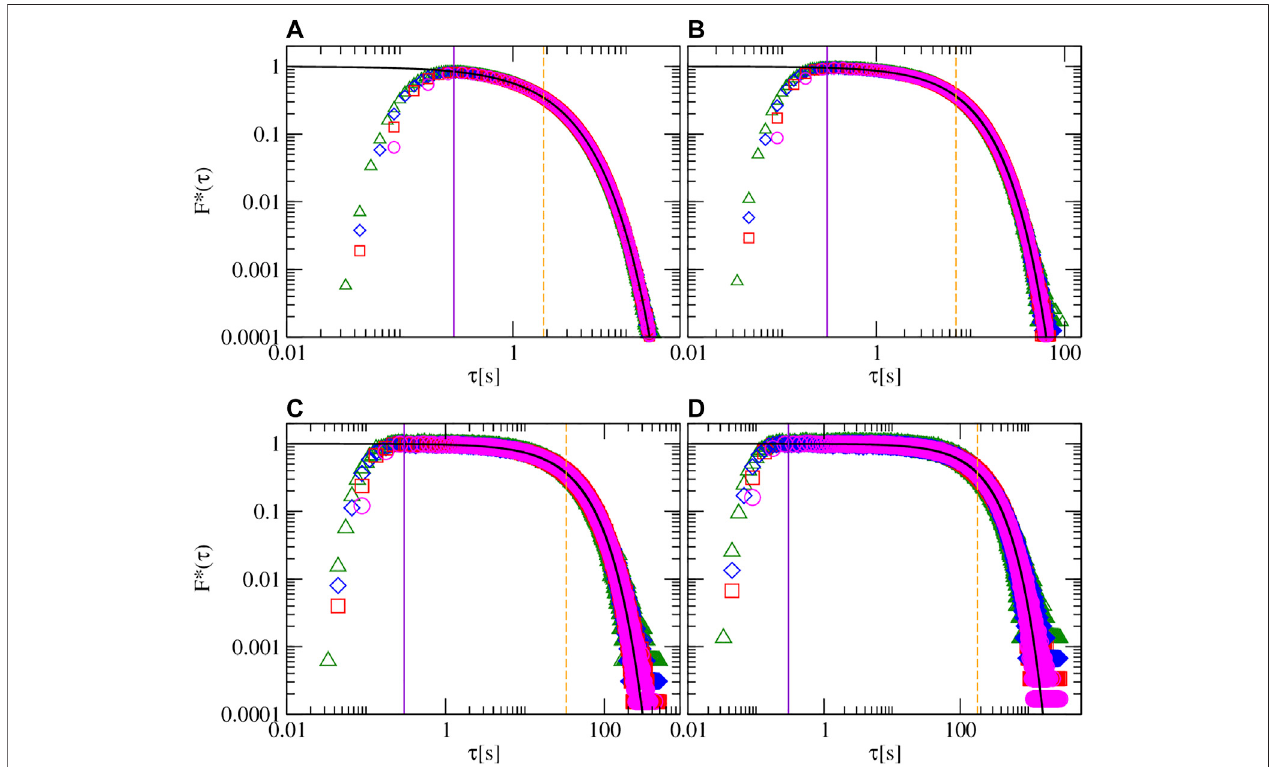
FIGURE 12 | (Color online): Normalized histograms of the fi rst passage times for different barrier heights U 0 and Δ t bins. Black lines are exponential tail fi ttings associated to Eq. 21 . Locants have the same meaning as that used in Figure 11 .